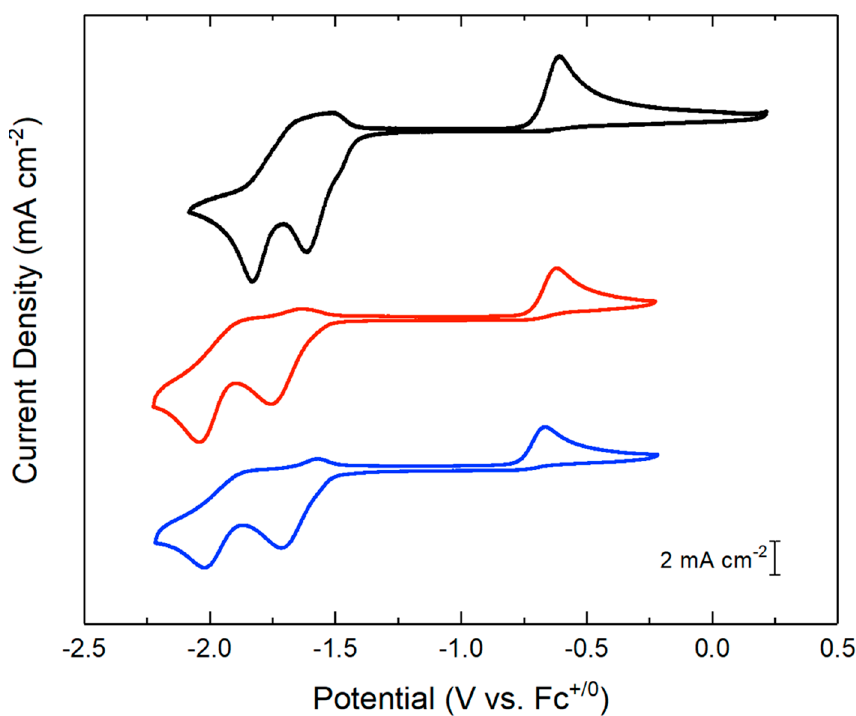
Figure 6. Cyclic voltammogram of complexes 1 (black), 2 (red), and 3 (blue) in MeCN solution with 0.1 M TBAPF 6 electrolyte (WE: HOPG, Psuedo Ref: Ag +/0 , CE: Pt, internal Ref: Fc +/0 ).